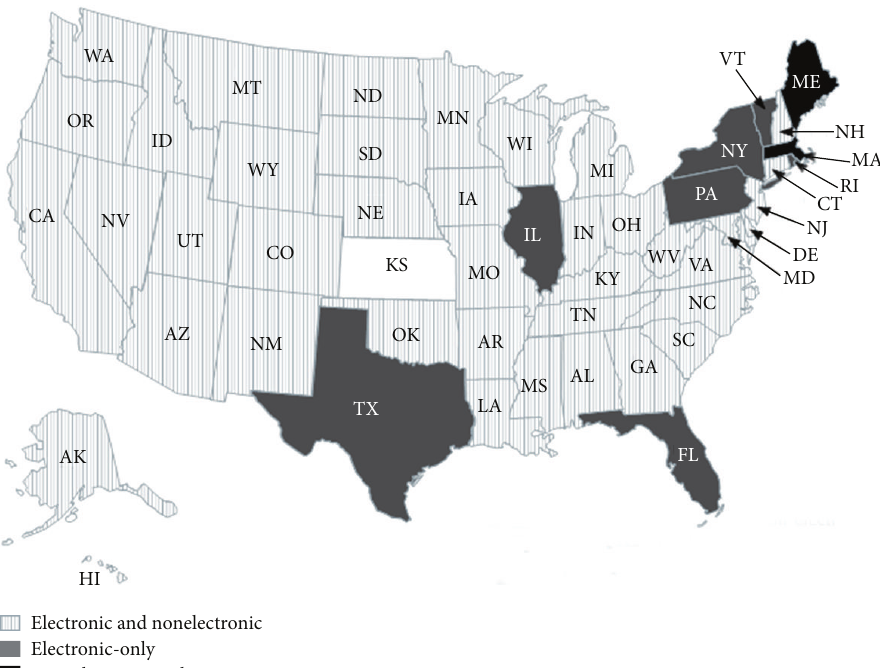
Figure 1: Distribution of reporting methods across state central cancer registries. Depiction of state cancer registries that allow reports of diagnosed melanoma cases in both an electronic or nonelectronic format, states that permit only electronic transmission, and states that are yet to have capabilities for electronic